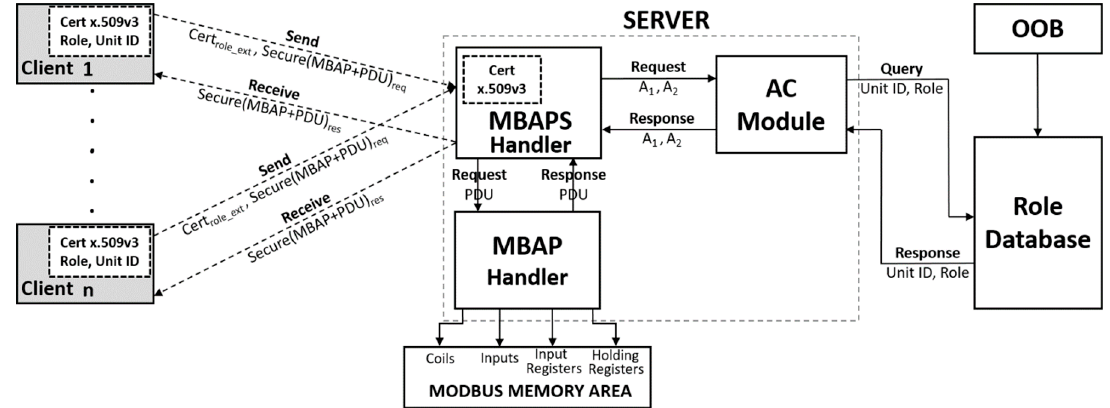
Figure 4. Role-based access control model (RBAC) based on centralized architecture.